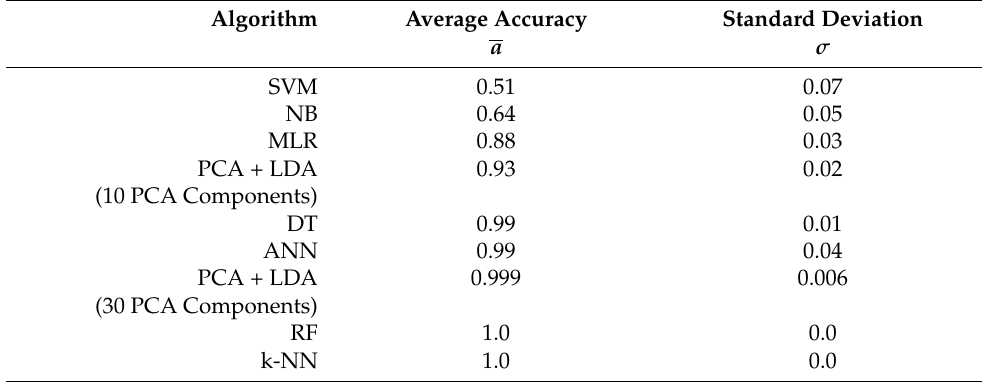
Table 3. Summary of results of the classification given by the average of the accuracy a and its standard deviation σ ; machine learning methods: Support vector machine (SVM), naïve Bayes (NB), multinomial logistic regression (MLR), principal component analysis (PCA) and linear discriminant analysis (LDA), decision tree (DT), random forest (RF), and k-nearest neighbor